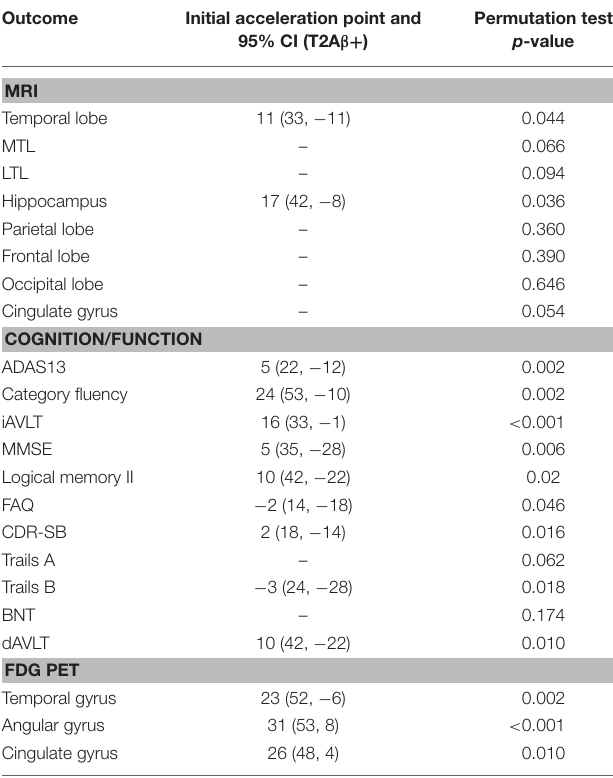
TABLE 1 | Estimates of initial acceleration points, 95% confidence intervals, and significance of permutations